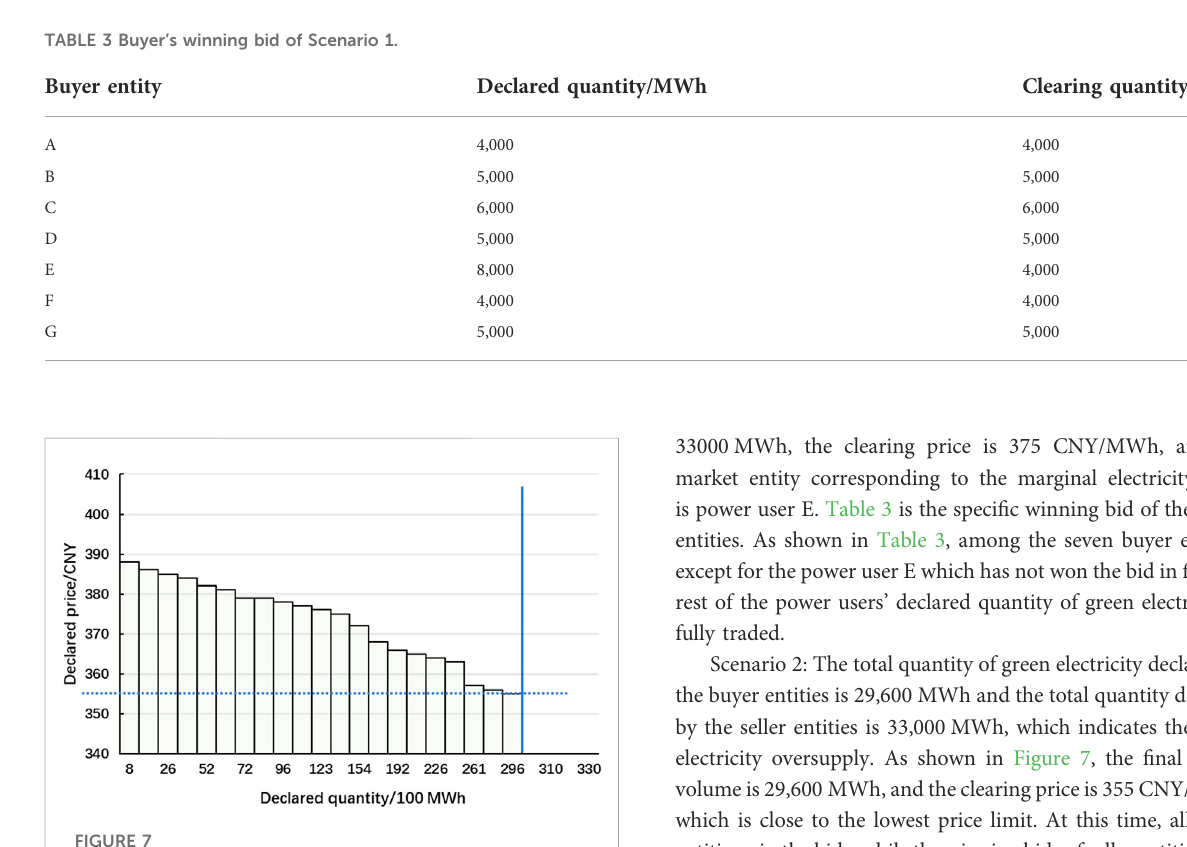
FIGURE 7 The results of clearing in the market of Scenario